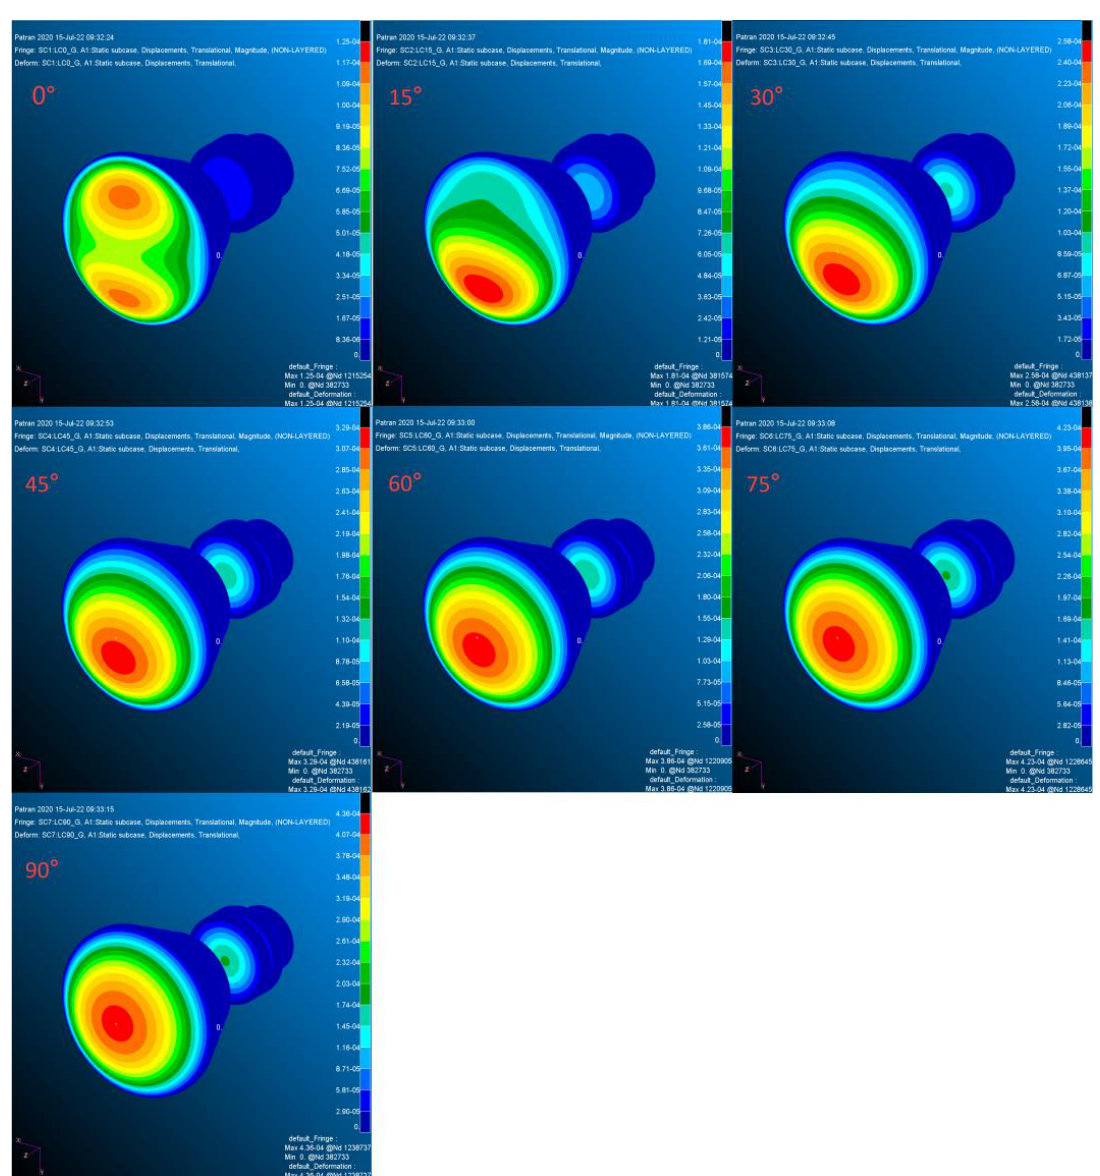
Figure 8. Deformation diagram under the action of gravity.